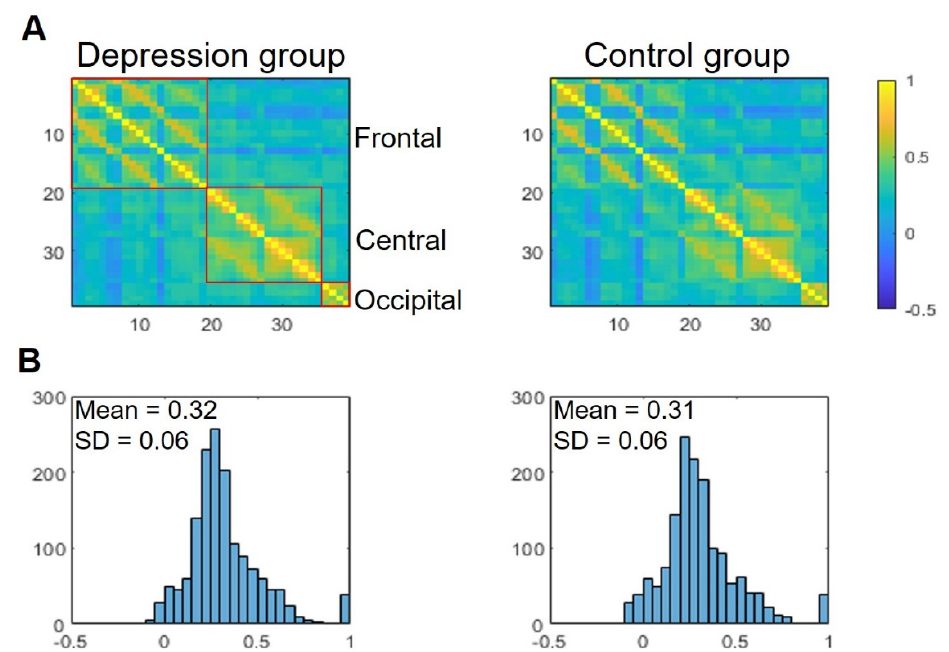
Figure 2. ( A ) The averaged group-level resting-state functional connectivity (as indexed by r value correlation matrices) of the depression and control groups. Digits in matrices indicate measurement channels. Frontal, central, and occipital channels are clustered and highlighted. ( B ) The distribution of correlation matrices of the two groups.